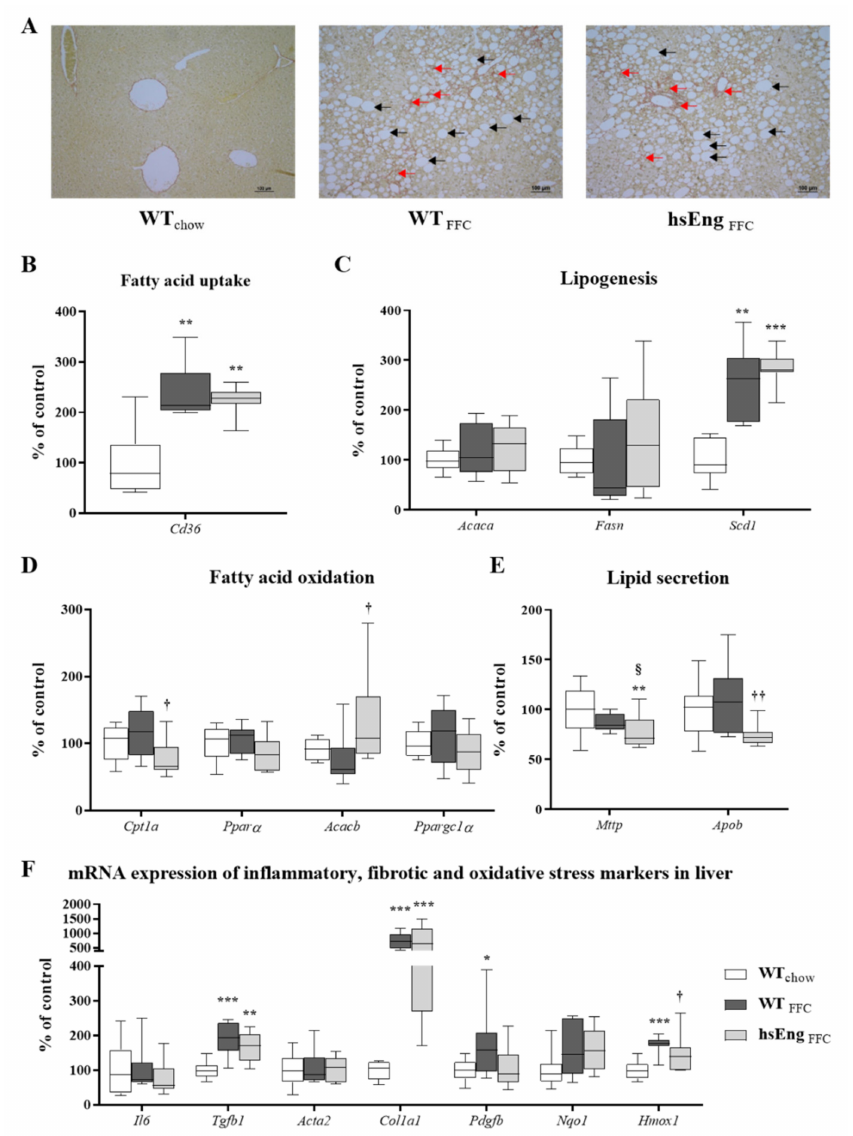
Figure 5. Evaluation of steatosis, fibrosis, inflammation, and oxidative stress in the liver. Sirius red-stained liver sections [macrovesicular steatosis–black arrows and mild fibrosis–red arrows] ( A ). mRNA expression of genes involved in FA uptake ( Cd36) ( B ), lipogenesis ( Acaca, Fasn, Scd1) ( C ) and oxidation ( Cpt1a, Ppar α , Acacb, Ppargc1 α ) ( D ). mRNA expression of genes involved in lipid secretion ( Mttp, Apob ) ( E ). Gene expression of inflammatory ( Il6) , fibrogenic ( Tgf- β 1 , Acta2, Col1a1, Pdgfb ) and oxidative stress ( Nqo1, Hmox1) markers ( F ). The data are presented as median with box and whiskers representing the interquartile range and 5th–95th percentiles ( n = 8). * p < 0.05, ** p < 0.01, *** p < 0.001, using the Kruskal–Wallis test; † p < 0.05, †† p < 0.01 using the Mann–Whitney test (WT FFC –hsEng FFC